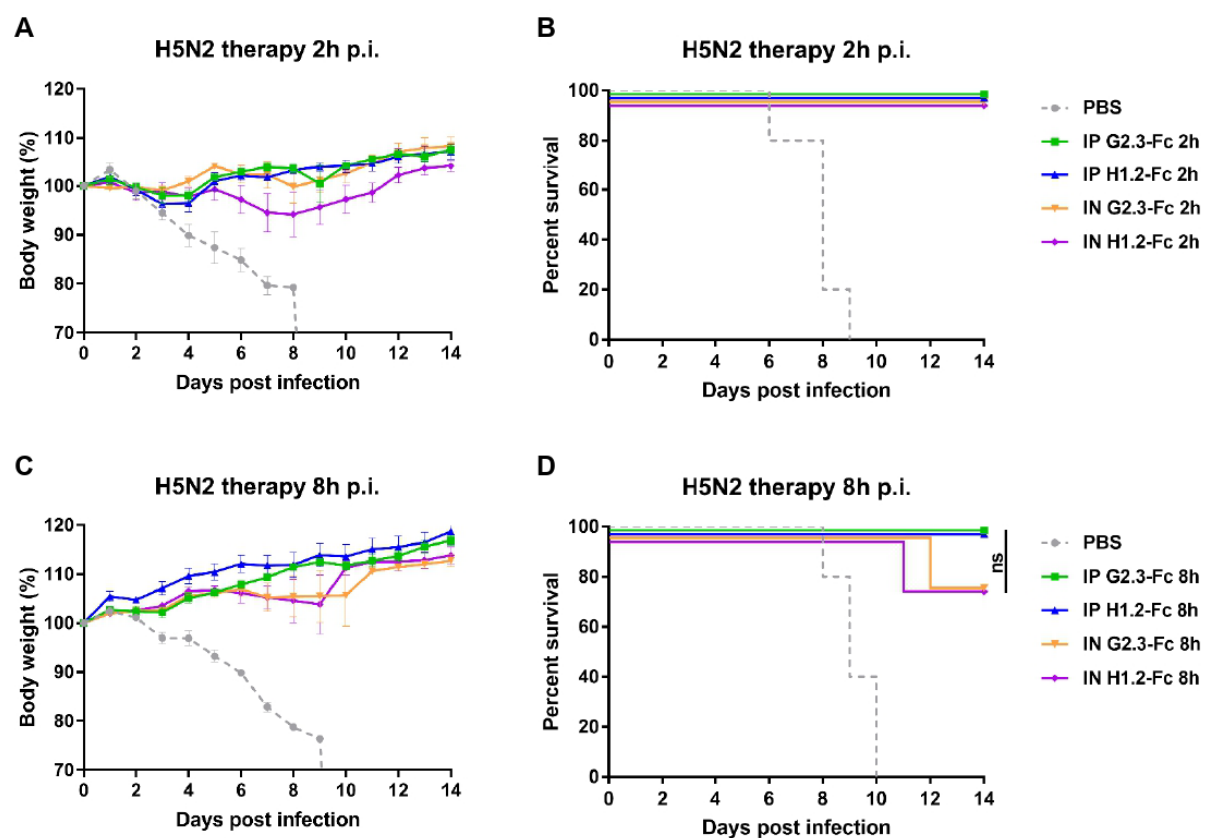
Figure 6. Therapeutic efficacy of VHH-Fc against H5N2 IAV in BALB/c mice. Body weights and survival curves of mice (n = 5 per group), treated with G2.3-Fc or H1.2-Fc with a dose of 10 mg/kg in case of i.p. injection or 2 mg/kg when delivered via the i.n. route. VHH-Fc were administered 2 h ( A , B ) or 8 h ( C , D ) after the infection with 5 LD 50 of influenza duck/PA/84(H5N2)ma virus. As a negative control, a vehicle (PBS) was administered 2 h ( A , B ) or 8 h ( C , D ) after the infection via the i.n. route. Body weight curves represent mean value ± SEM. ns—the difference between groups is non-significant.